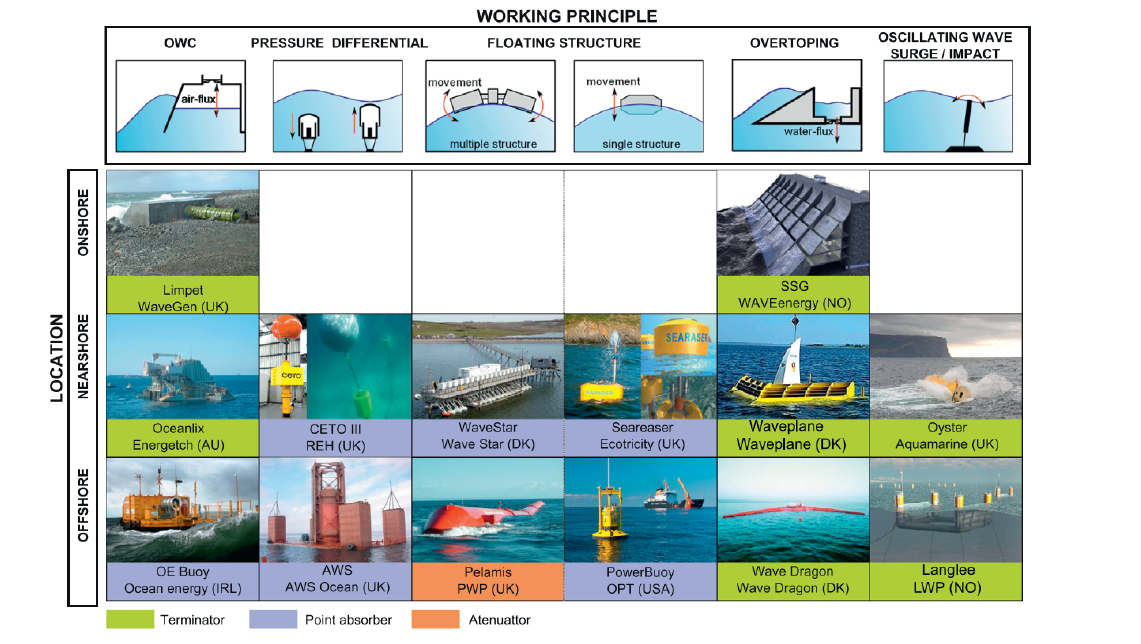
Figure 3. A classification of wave energy converters (WECs). Reproduced with permission from